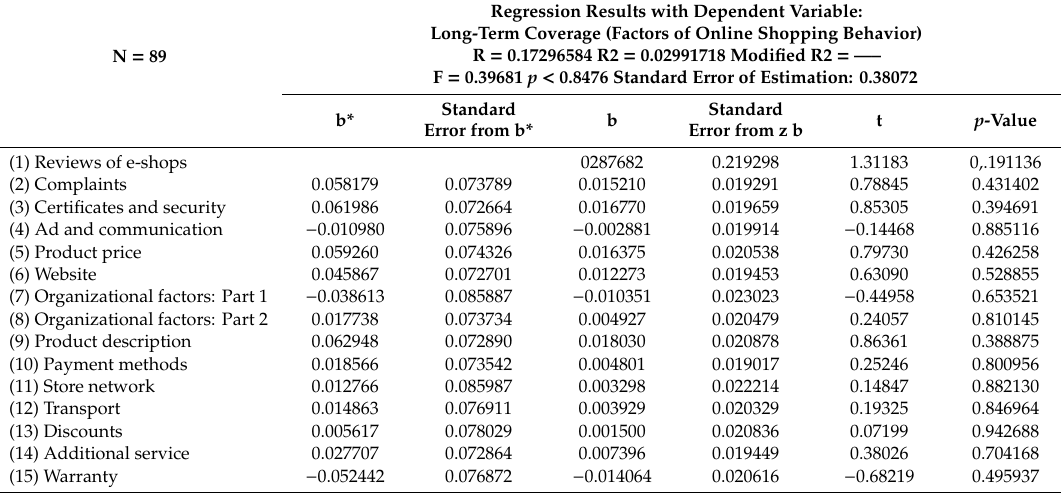
Table A5. Multiple regression between Long-term coverage and factors of online shopping behavior. Source: own processing (in the Statistica